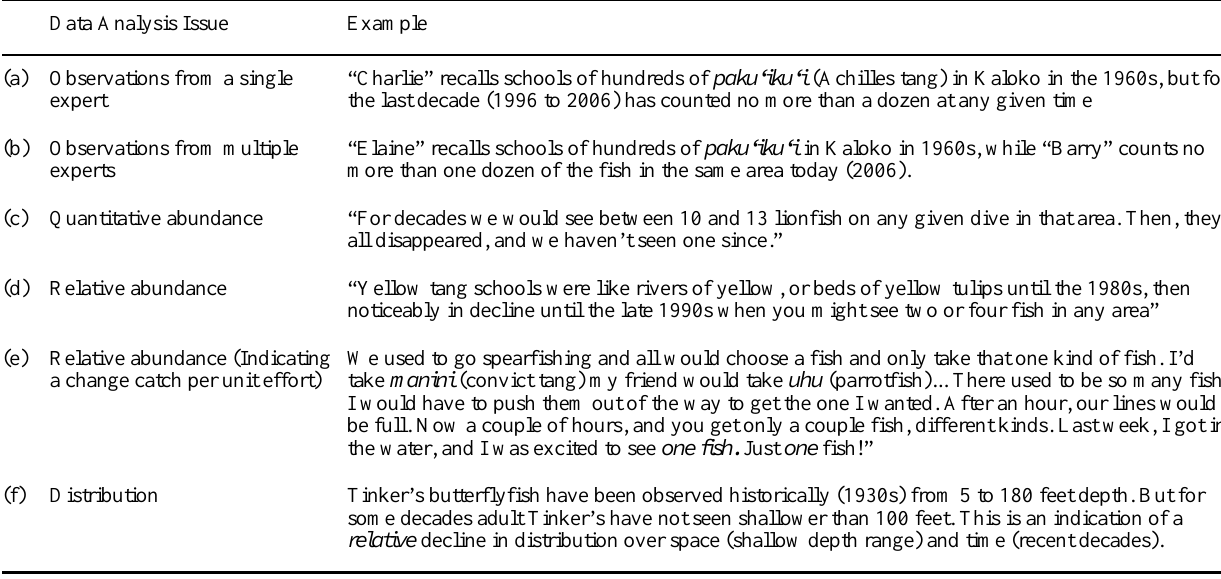
Table 1. Qualitative analysis of interview texts. All scientific, common, and Hawaiian names of marine organisms are given in Table